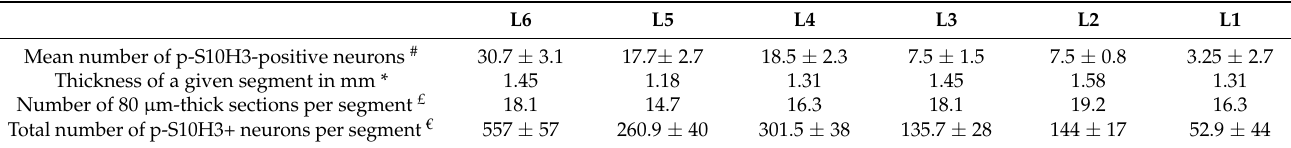
Figure 1. Burn injury-induced S10H3 phosphorylation is mainly located in the superficial dorsal horn (SDH) and displays unequal distribution within the spinal lumbar segments (L1–L6) in mice. ( a ) Innoxious stimulation (37 °C for 2 min) did not induce the phosphorylation of S10H3 in the SDH. ( b ) Burn injury (60 °C for 2 min) induced a robust phosphorylation of S10H3 in the ipsilateral SDH only. Both sections ( a , b ) were taken from L5 spinal segments. Dotted lines indicate the border between gray and white matter. ( c ) Burn injury-induced p-S10H3 expression shows unequal rostrocaudal distribution, with a peak expression in L6. Data presented as box plots are from 80-µm-thick sections taken from each segment (4–9 sections per segment from 3 animals). Dots indicate outlier values. * p < 0.05. Table 1. Evaluation of the total number of p-S10H3-positive neurons in each lumbar segment (L6–L1) of mouse spinal cord following burn injury (n = 3